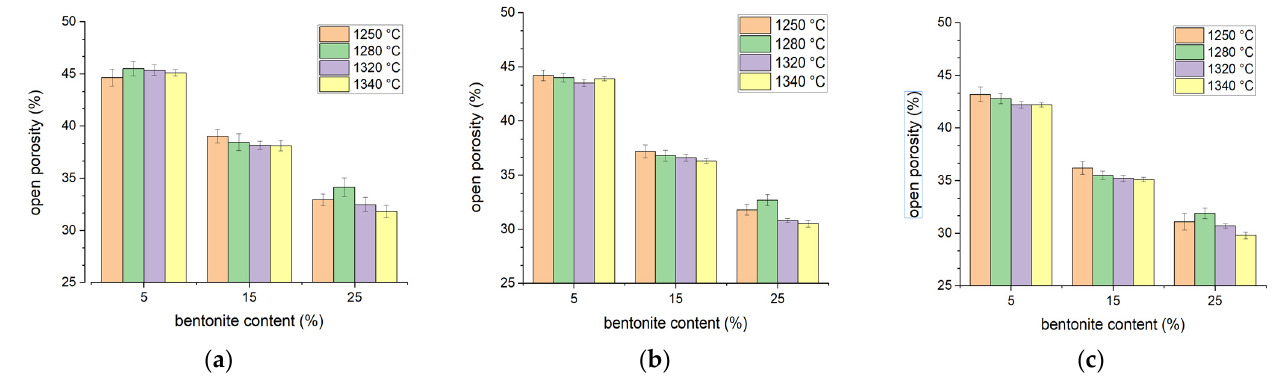
Figure 6. Content of bentonite binder vs. open porosity of ceramics based on hollow alumina microspheres (HAM) pressed at ( a ) 20; ( b ) 30; and ( c ) 40 MPa. Sintering temperature is indicated in a legend.